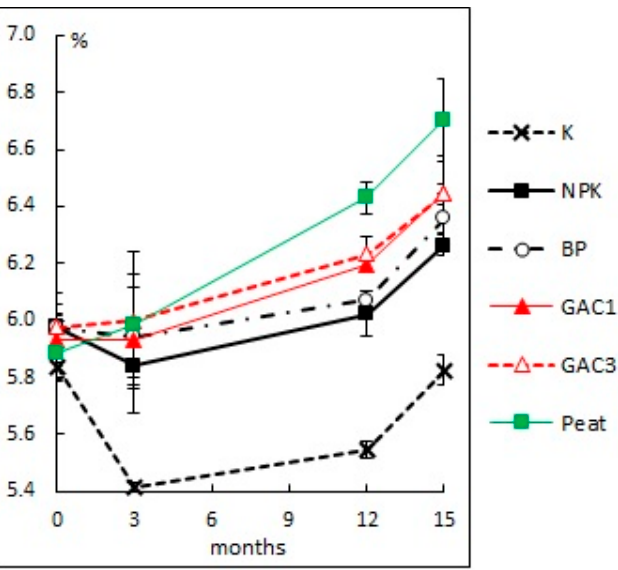
Figure 5. The change of soil pH with various methods of bioremediation.